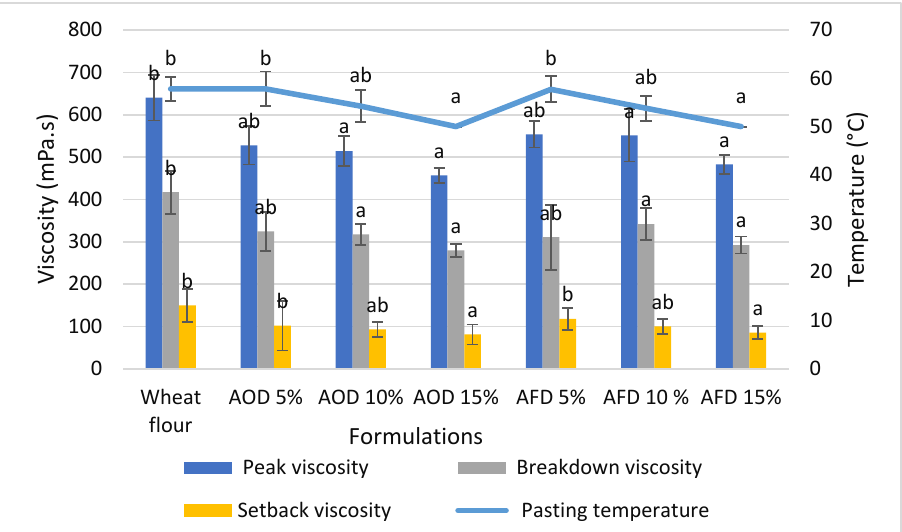
Figure 1. Effect of cricket flour on pasting properties of wheat flour and cricket flour blends. Results are presented as the mean of three replicates. Error bars correspond with ± standard deviations. Different letters mean statistically different values ( p < 0.05). WF = Wheat Flour; AOD = A. domesticus oven dried; AFD = A. domesticus freeze dried.